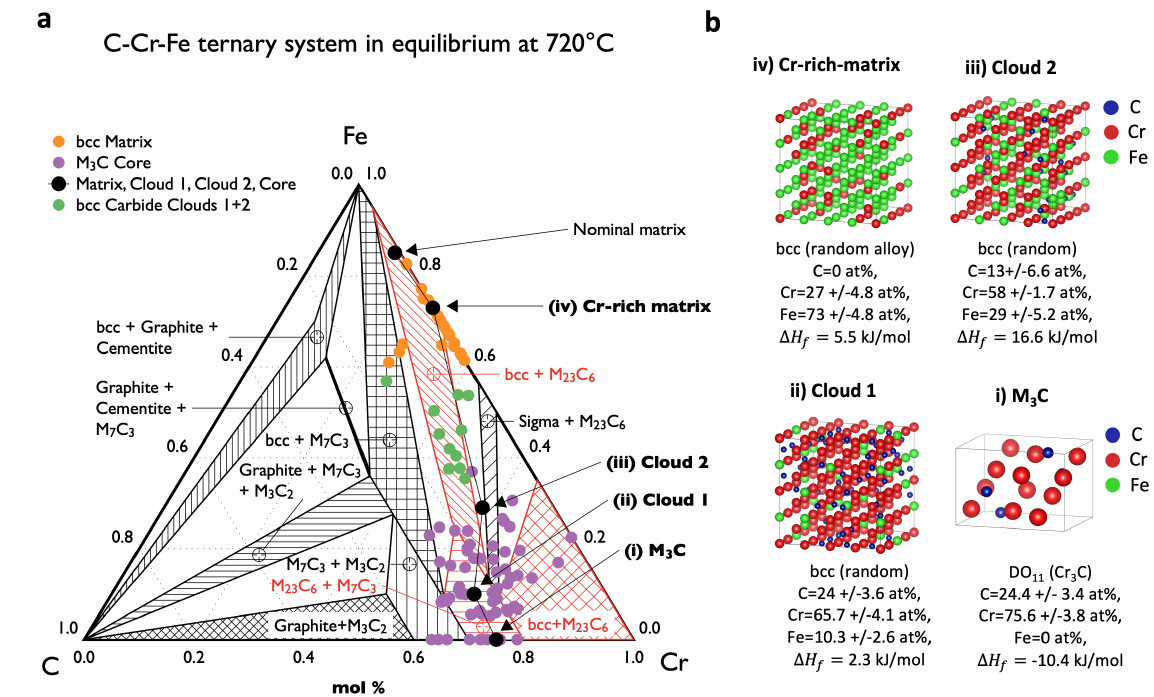
Figure 5. ( a ) The ternary Fe-Cr-C system at 720 ◦ C with equilibrium data taken from FactSage [50]. The dots indicate data from the chemical profile in Figure 4b, for the M 3 C core and bcc carbide Clouds 1 and 2 used for the DFT calculations in ( b